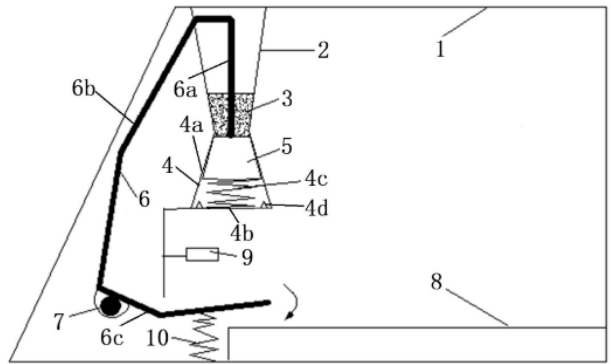
Figure 2. Dust inhalation experimental device for an animal model of coal workers’ pneumoconiosis [47]. 1. Feeding cage; 2. dust bin; 3. dust; 4. nozzle assembly; 4a. nozzle cover; 4b. nozzle base plate; 4c. return spring; 5. conical slider; 6a. connecting rod assembly; 6b and 6c. connecting rod shaft;